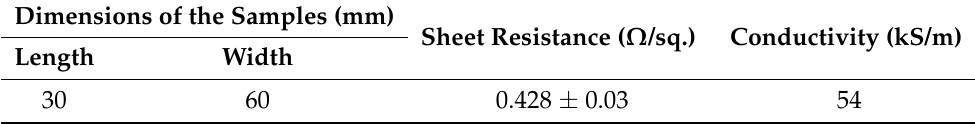
Table 2. Electrical properties of SIGP.